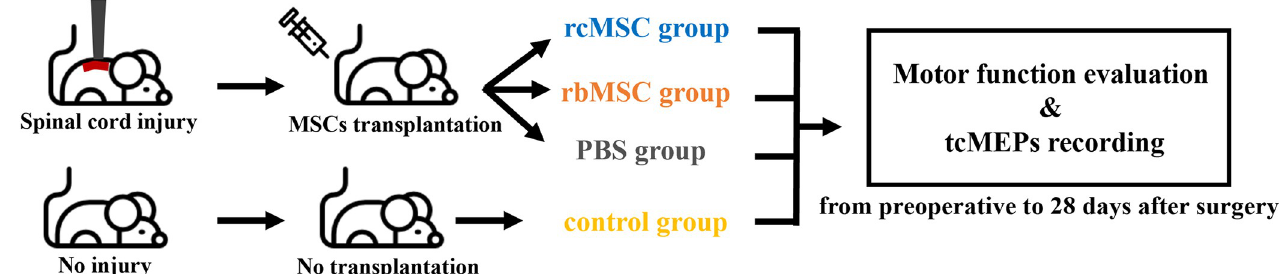
Fig 1. Outline of the present experiment. The rats were subjected to random grouping and a repeated-measures behavioral and electrophysiological study protocol from the preoperative stage to 28 days after surgery. We used the Basso–Beattie–Bresnahan scale and inclined plane task score as a behavioral endpoint and transcranial electrically stimulated motor-evoked potential (tcMEP) as an electrophysiological endpoint of neurological function